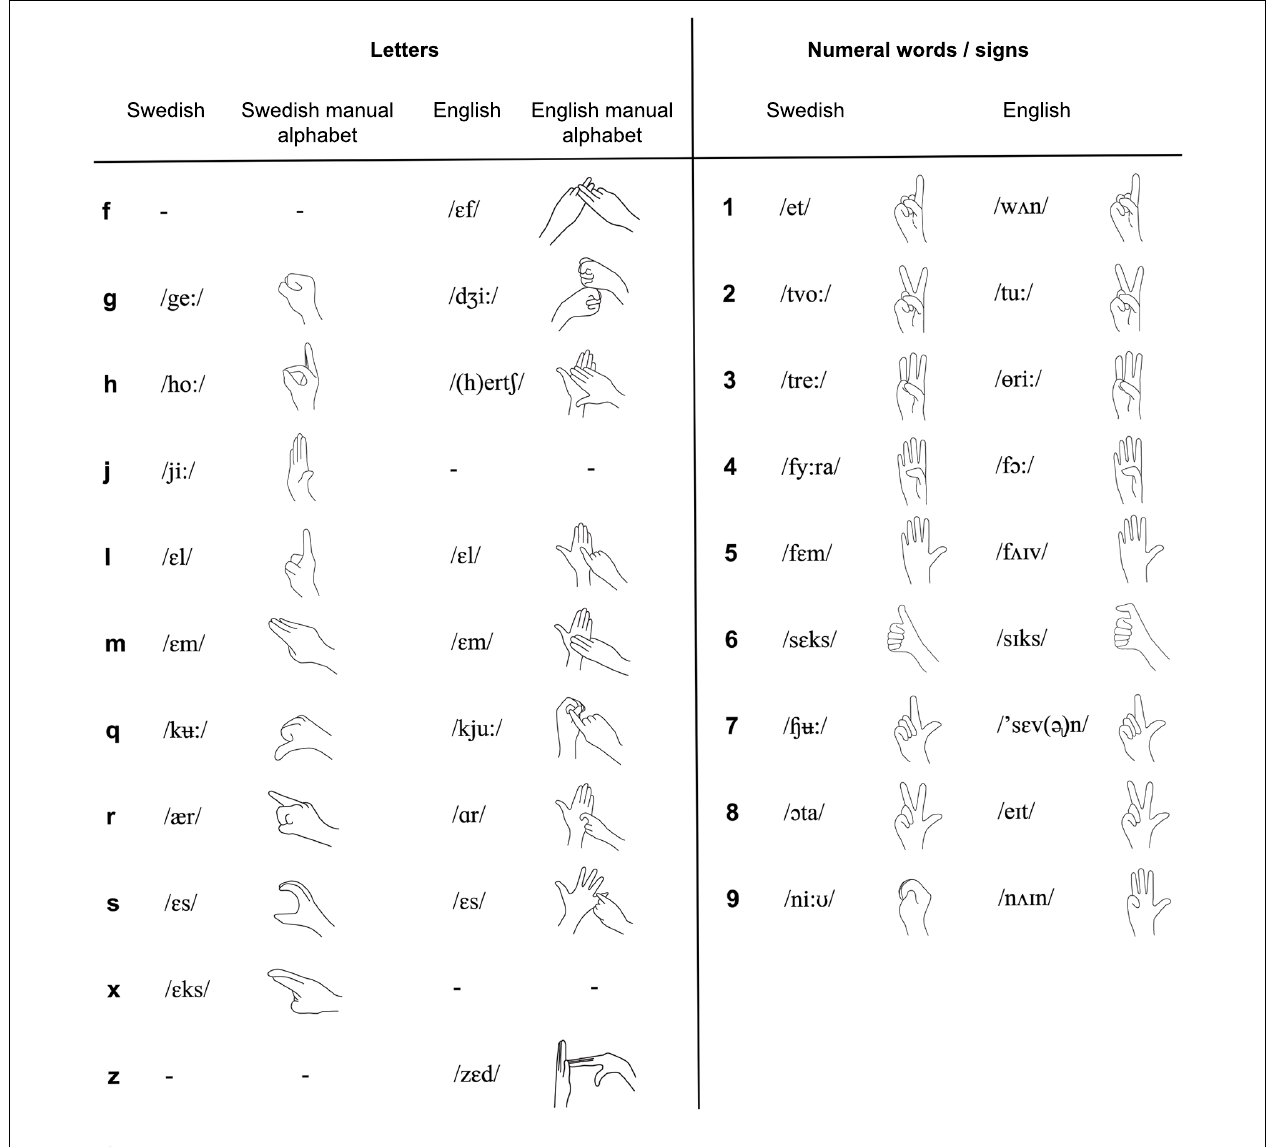
phonetic alphabet for pronunciation in Swedish and English. Note that the illustrations for BSL manual numerals represent the traditional manual numerals used in London, from which most of the BSL users in the present study originated, but there is extensive variation, in particular in the numbers